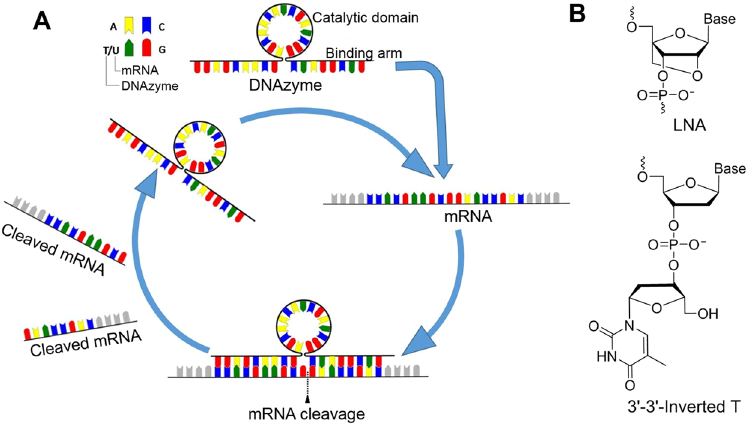
Figure 1. ( A ) Schematic illustration of DNAzyme-based mRNA cleavage, and ( B ) structural representations of LNA and inverted thymidine